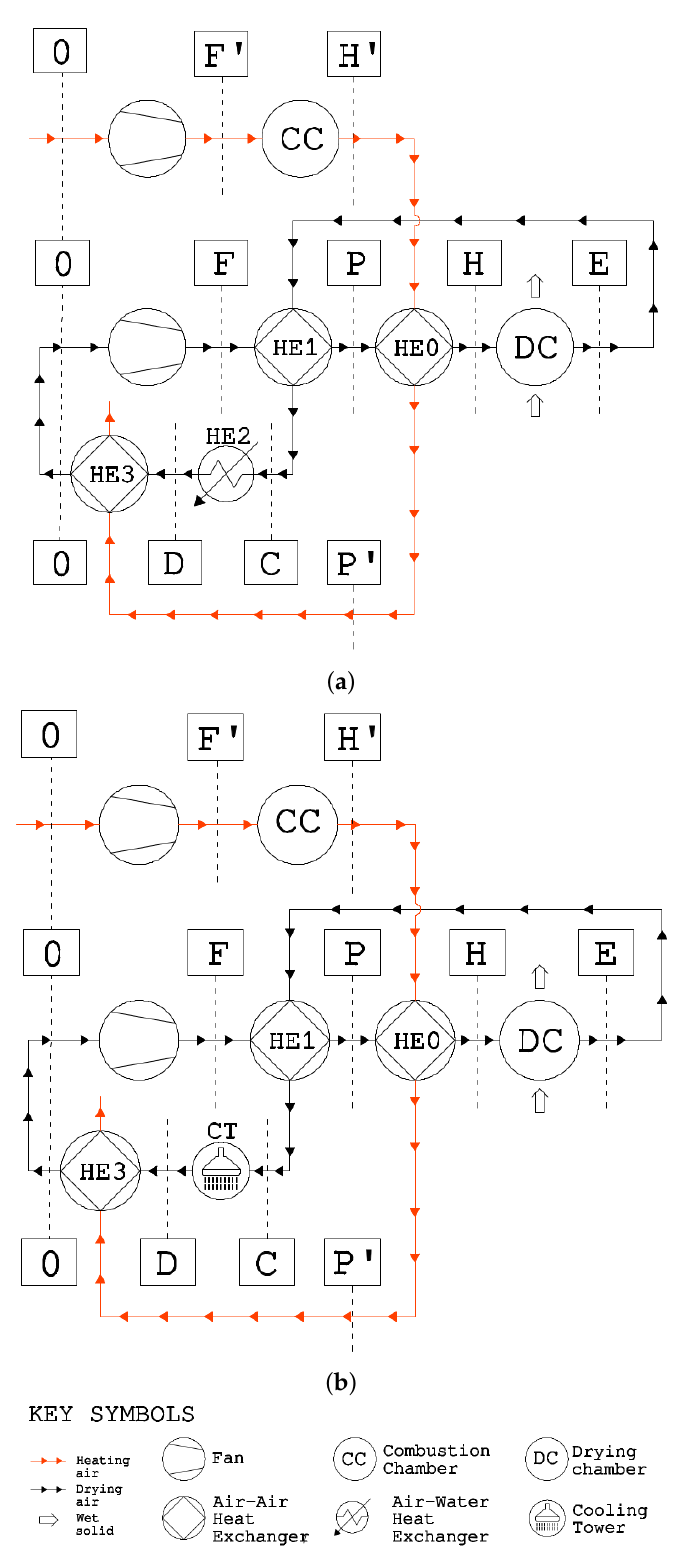
Figure 9. Closed cycles are Scenarios 2 ( a ) and 3 ( b ): An external combustion system keeps the chemical composition of the drying air unaltered; the latter is regenerated at the initial conditions by a cooling and a post-heating